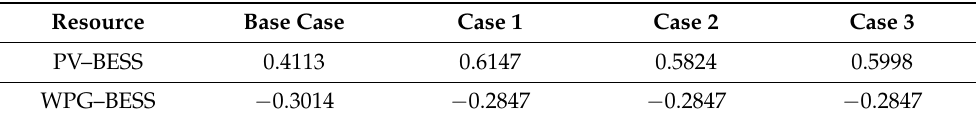
Table 15. Correlation between SMP and output measured at PCC controlled.